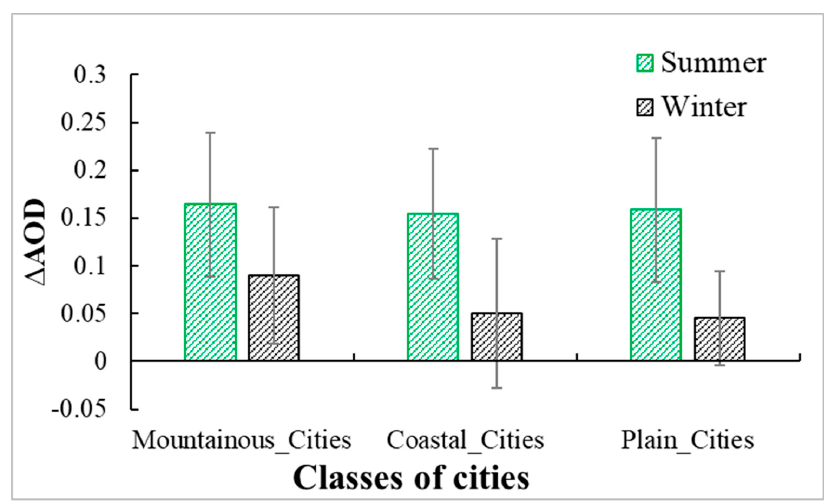
Figure 13. The ∆ AODs of mountainous cities, coastal cities, and plain cities in summer (green bars) and winter (black bars) .